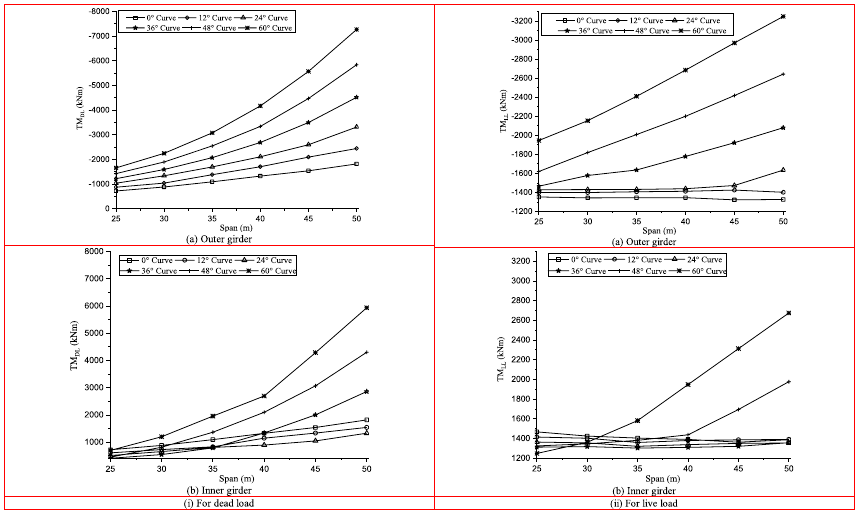
Fig. 15 Variation of torsional moment with span for different curve angle. a Outer girder. b Inner girder. (i) For dead load. (ii) For live